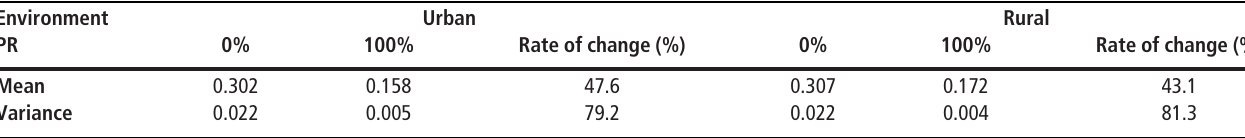
Table 4 Quantitative difference of the GEF between two intersection environments